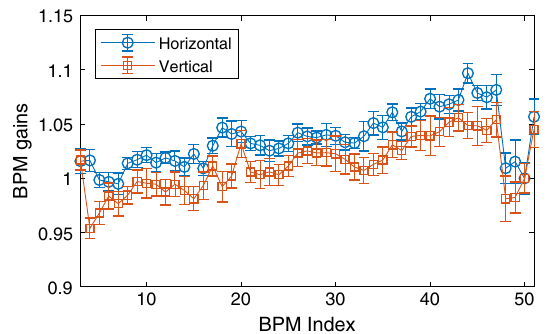
FIG. 11. Fitted BPM gains for the L3 linac BPMs. The gains are scaled for BPM gain #50 to be 1.0.